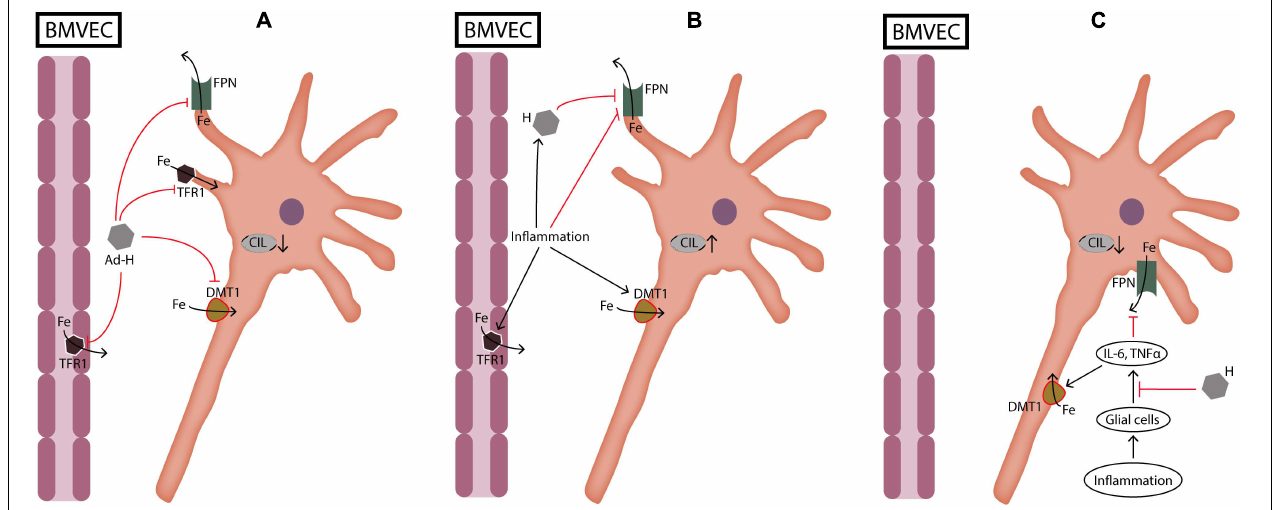
FIGURE 2 | Dual role of hepcidin during neuronal cellular iron load and inflammation. (A) During cellular iron load not caused by inflammation hepcidin protects neurons by reducing iron transport through BMVEC and by reducing iron import into neurons. (B) During inflammation hepcidin production induced by cytokines is deleterious for neurons because it increases iron load by inhibiting iron export through FPN. On the other hand, inflammation increases iron import into cells which further aggravates cellular iron load. (C) When glial cells are pretreated with hepcidin, cellular iron load is decreased because hepcidin suppresses the release of cytokines from glial cells. Ad-H, ad-hepcidin; BMVEC, brain microvascular endothelial cells; CIL, cellular iron load; DMT1, divalent metal transporter 1; Fe, iron; FPN, ferroportin; IL-6, interleukin-6; TFR1, transferrin receptor 1; TNF α , tumor necrosis factor α